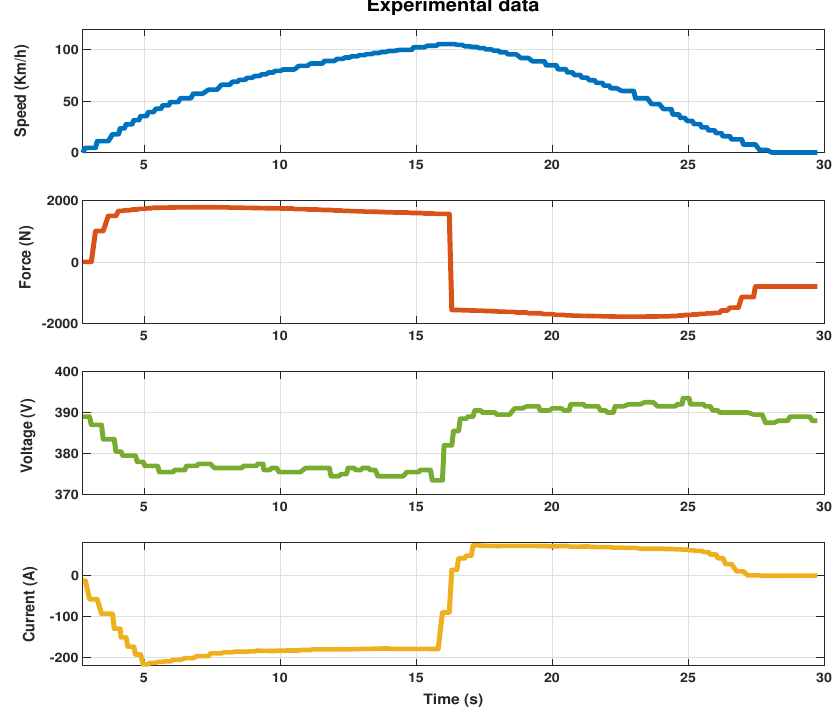
Figure 7. Data collected from vehicle CAN bus: vehicle speed, required force at the wheels, battery voltage, and battery current (from top to